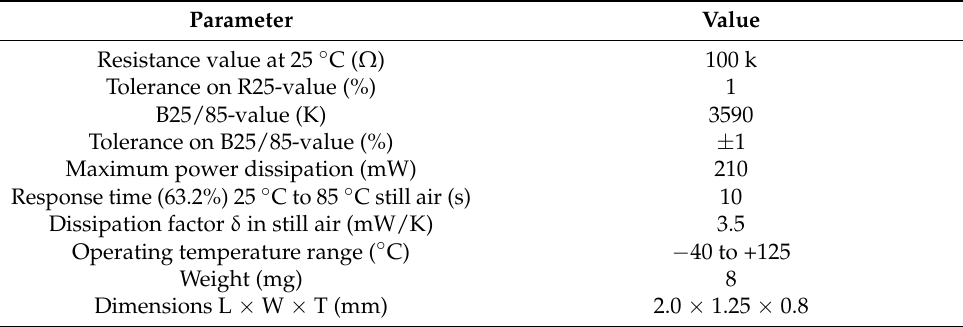
Table 3. Characteristics of the NTCS0805E3104SMT sensor.